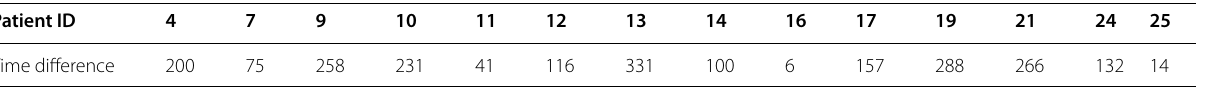
Table 3 The time response comparison between the new index and the BIS (in seconds) Patient